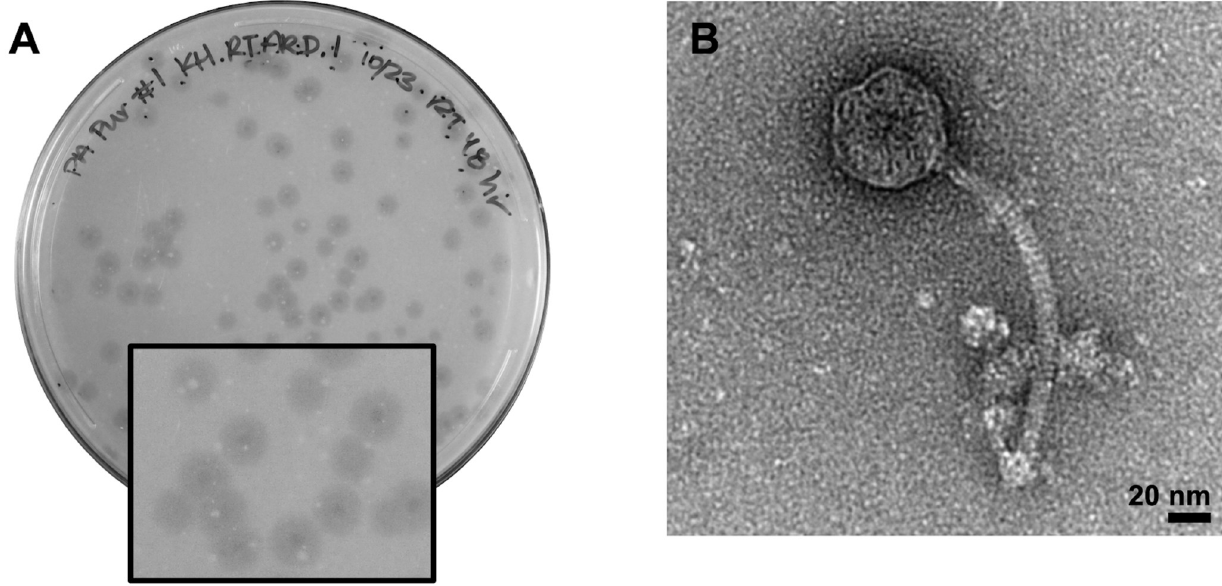
Fig 1. BlueFeather is a siphovirus. A . Plaque morphology was inconsistent with some bullseye plaques containing 1 mm center clearings with varying degrees of turbidity. Plaque sizes ranged from 2–5 mm in diameter, with an average plaque diameter of approximately 3.5 mm. B . TEM image of BlueFeather at 67,000X magnification. The capsid was estimated to be 48 ± 8 nm and the tail 156 ± 53 nm.